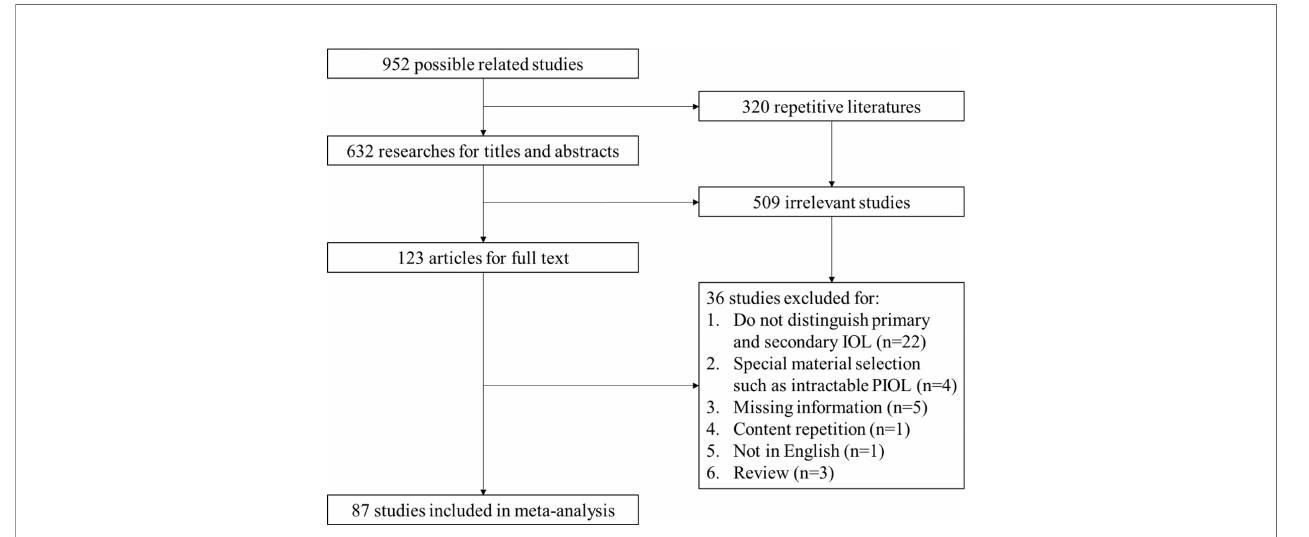
FIGURE 1 | PRISMA fl ow of screening process. IOL, Intraocular Lymphoma; PIOL, Primary Intraocular